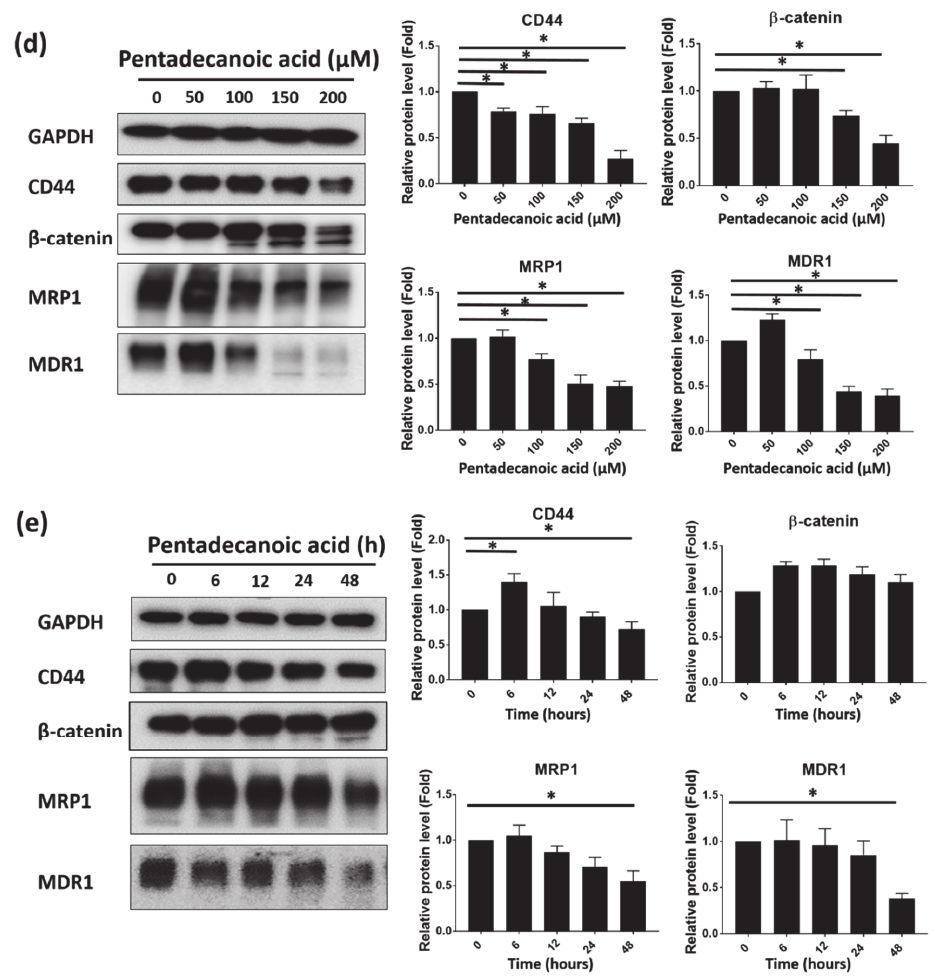
Figure 4. Pentadecanoic acid suppresses the stem like-cell characteristics of MCF-7 / SC. ( a ) E ff ects of pentadecanoic acid on MCF-7 / SC mammosphere formation (magnification 100 × ). ( b , b’ ) The e ff ects of pentadecanoic acid on the expression of cell surface markers in MCF-7 / SC were analyzed by FACS analysis following pentadecanoic acid exposure. ( c ) Flow cytometry analysis of the ALDH + population using the ALDEFLUOR assay kit. Cells were treated with pentadecanoic acid for 48 h prior to the assay. ( d ) The levels of cancer stem cell (CSC) markers were assessed by Western blot experiments following pentadecanoic acid treatment for 48 h. ( e ) The levels of CSC markers as assessed by Western blot experiments following 100 µ M pentadecanoic acid exposure. GAPDH was used as a loading control. Data are shown as the mean ± standard deviation of three biologically independent